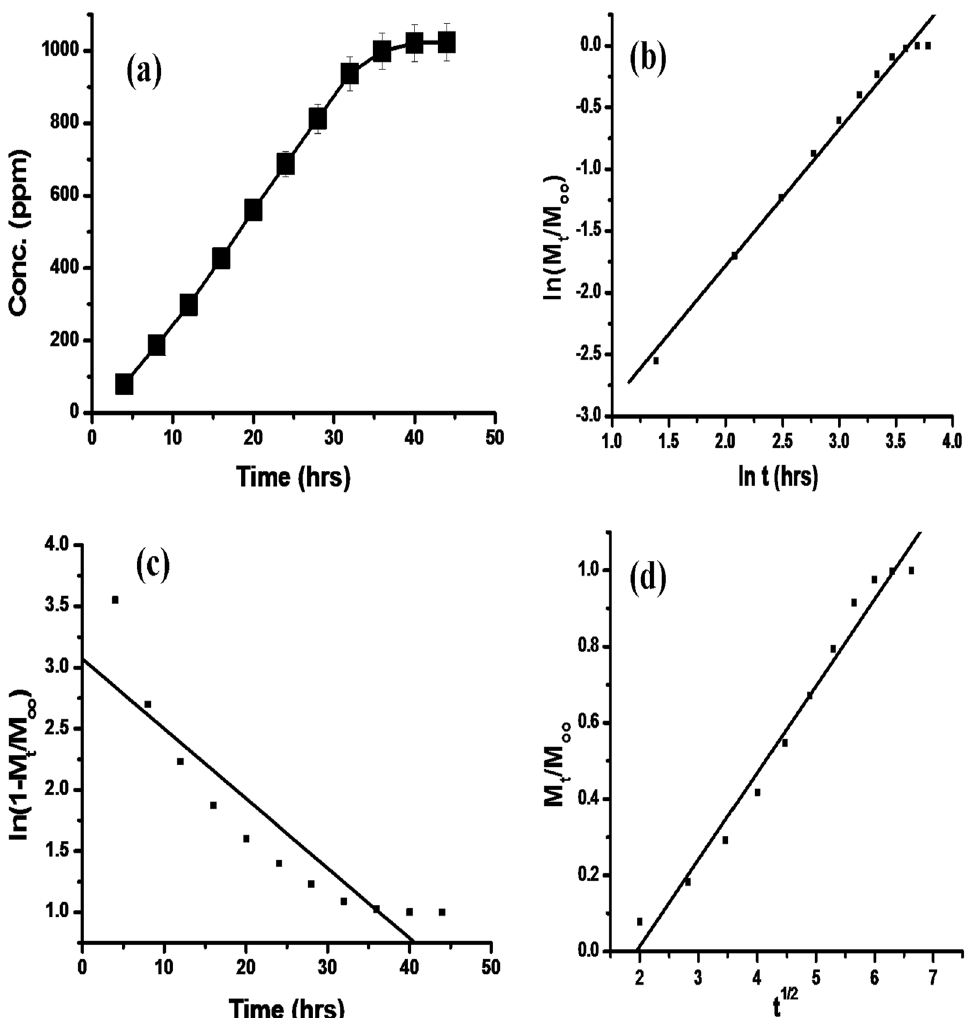
Fig. 9 a–d Release behavior of dichlorvos through Av-cl-poly(AA) at different time intervals a conc. versus time; b ln( M t / M ln(1 M t / M ) versus time and d M t / M − ∞